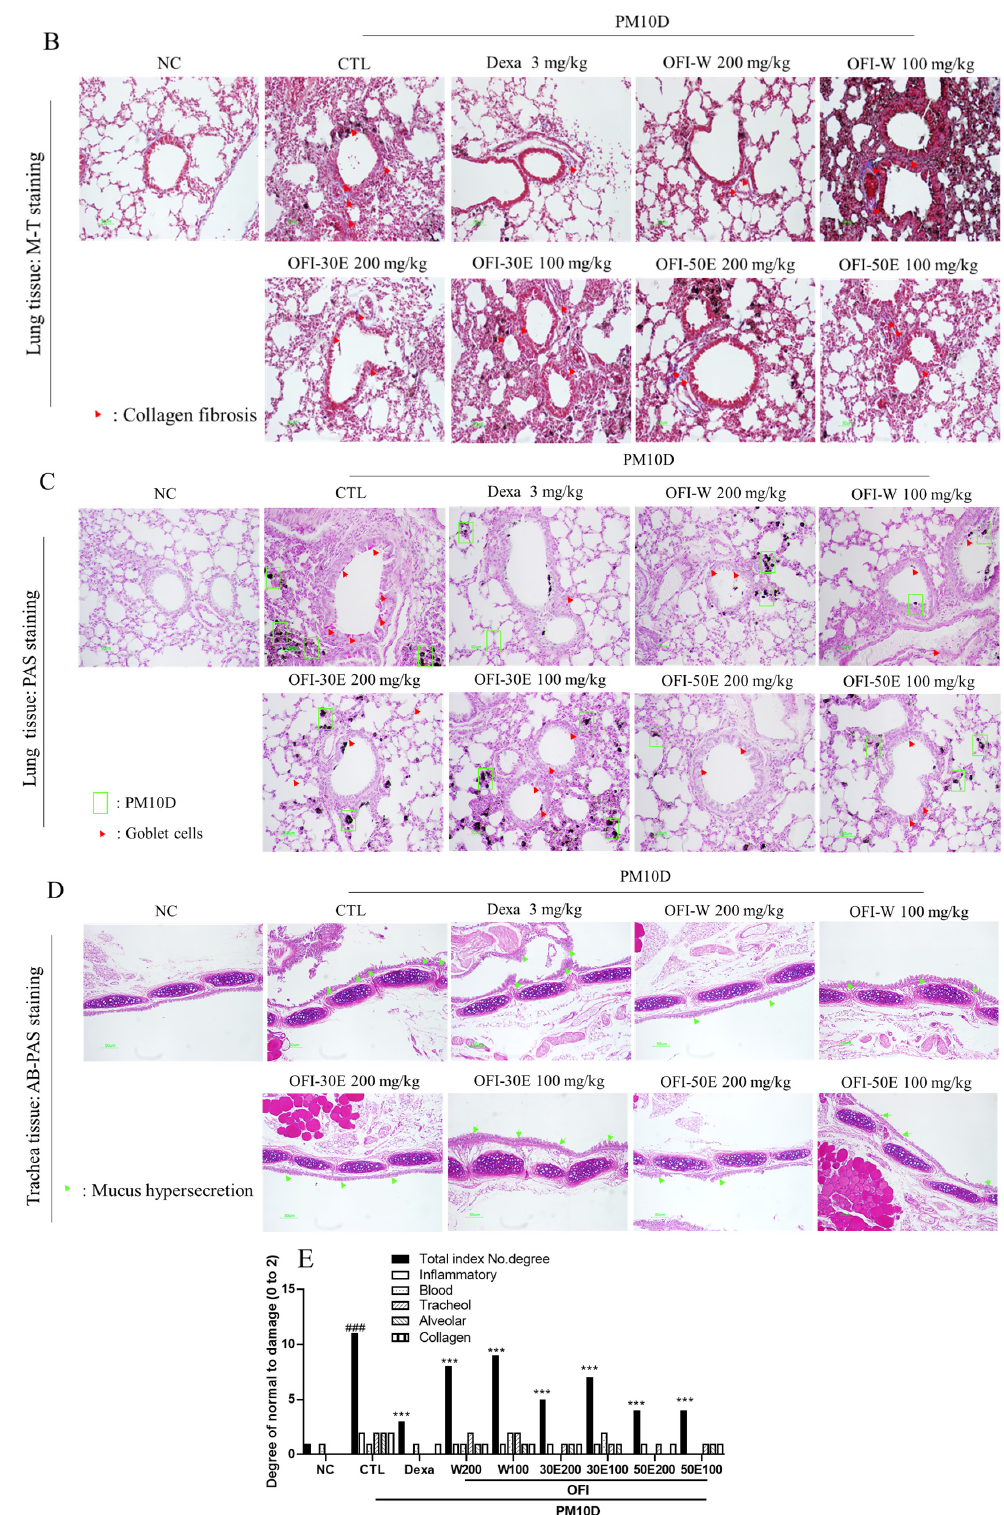
Figure 6. Effects of water and ethanolic extracts of OFI on lung and trachea histopathology in a PM10D-induced airway inflammation model. ( A ) Hematoxylin and eosin (H&E), ( B ) Masson’s trichrome (MT), ( C ) periodic acid-Schiff (PAS) staining of lung tissues, ( D ) Alcian blue ( A , B )-PAS staining of tracheal tissue, and ( E ) quantitative analysis of the degree of lung tissue damage. BALB/c normal control group; CTL: PM10D-induced control group; Dexa: 3 mg/kg dexamethasone-treated PM10D-induced group; OFI-W 100 and 200: PM10D-induced group treated with 100 and 200 mg/kg OFI-water extract, respectively; OFI-30E 100 and 200: PM10D-induced group treated with 100 and 200 mg/kg OFI-30% ethanol extract, respectively; OFI-50E 100 and 200: PM10D-induced group treated with 100 and 200 mg/kg OFI-50% ethanol extract, respectively. Data are expressed as means ± SEM, n = 8. ### p < 0.005 vs. NC; *** p < 0.005 vs. CTL. 2.8. Effects of PM10D on the Inflammatory Response in the Lung Particle pollutants trigger and exacerbate inflammation. Inhaled fine particulates are engulfed by alveolar macrophages and induce alveolar macrophage cell death via pyrop- tosis. Dead cell-derived factors such as IL-1 α / β are released and form inducible bronchus- associated lymphoid tissues (iBALT), which may contribute to particulate-pollution-in- duced inflammation [11,12]. During pyroptosis, caspase-1 expression and the formation of the NLRP3 inflammasome are increased [11]. To investigate the effects of dexame- thasone on PM10D-induced airway inflammation, inflammatory cell death (pyroptosis) was evaluated in PM10D-exposed mice receiving dexamethasone. Expression of cleaved caspase-3 was increased in the lungs of PM10D-exposed mice receiving dexamethasone compared to that in untreated PM10D-exposed mice (Figure 7A). PM10D also increased the expression of NLRP3 and caspase-1 in the lung, which was suppressed by the admin- istration of dexamethasone (Figure 7B). Moreover, PM10D increased the expression of the macrophage marker F4/80 and IL-1 α in the lungs (Figure 7C). These results indicate that PM10D induces inflammatory alveolar macrophage death via pyroptosis and not apopto- sis.